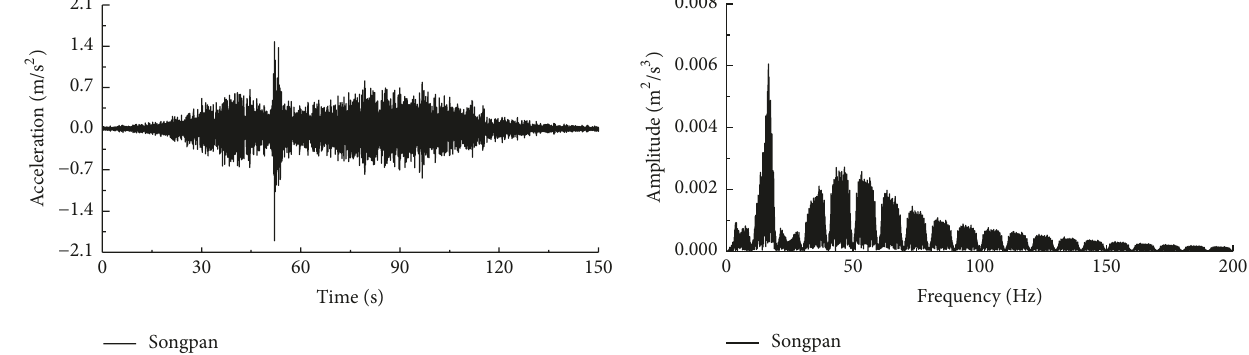
Figure 25: Vertical acceleration time history and Fourier spectrum curves at node 103 under Songpan